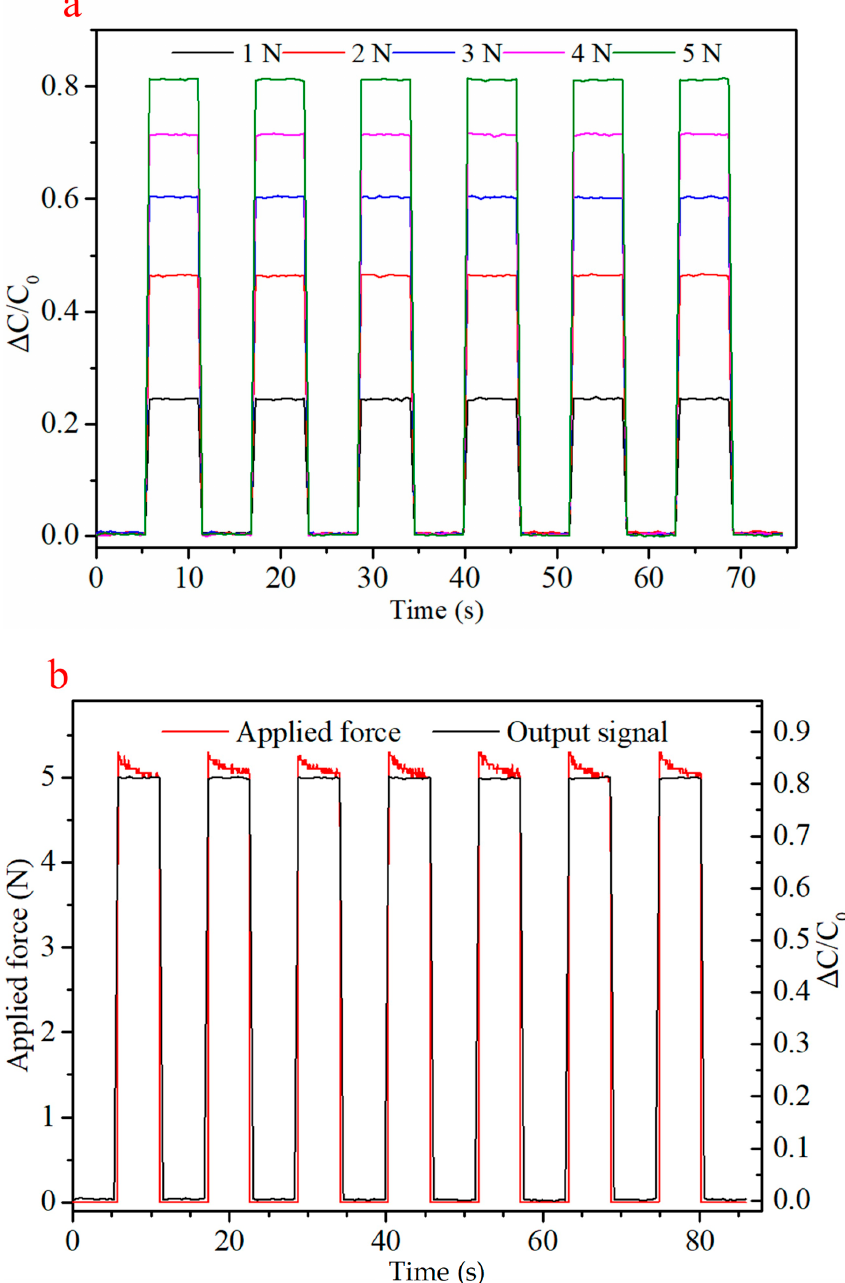
Figure 6. ( a ) Capacitive response of the pressure sensor to applied loads of 1, 2, 3, 4 and 5 N. ( b ) Capacitive response and mechanical relaxation for the material under repeated application and removal of a 5 N load.